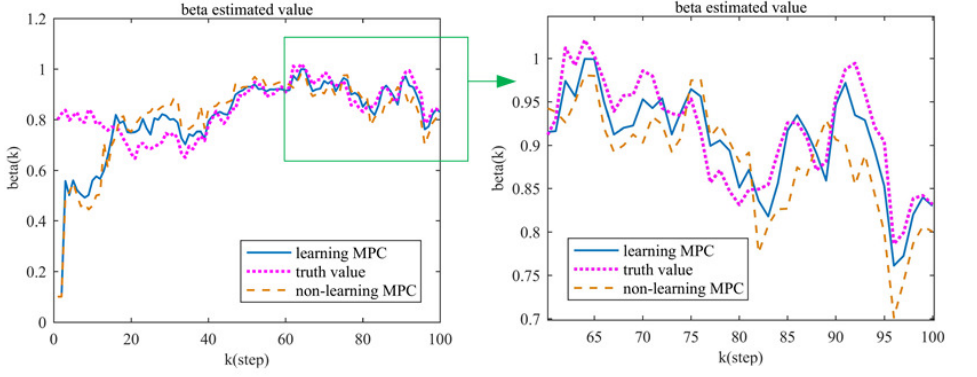
Figure 6. Estimated and true β ( k ) values when the parameter varies with